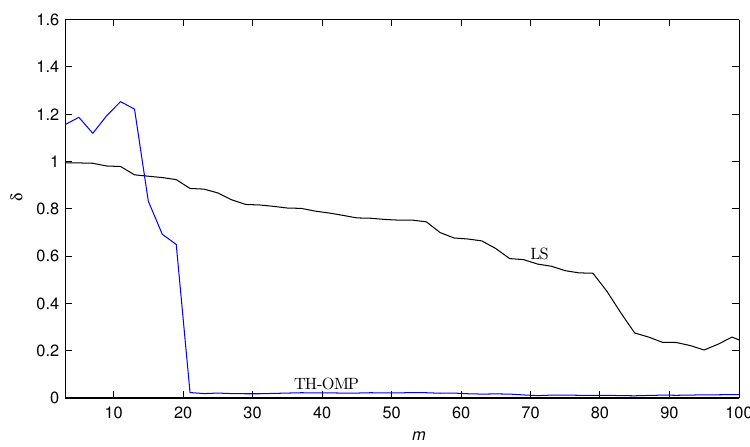
Figure 2. The estimation error δ versus m measurements.